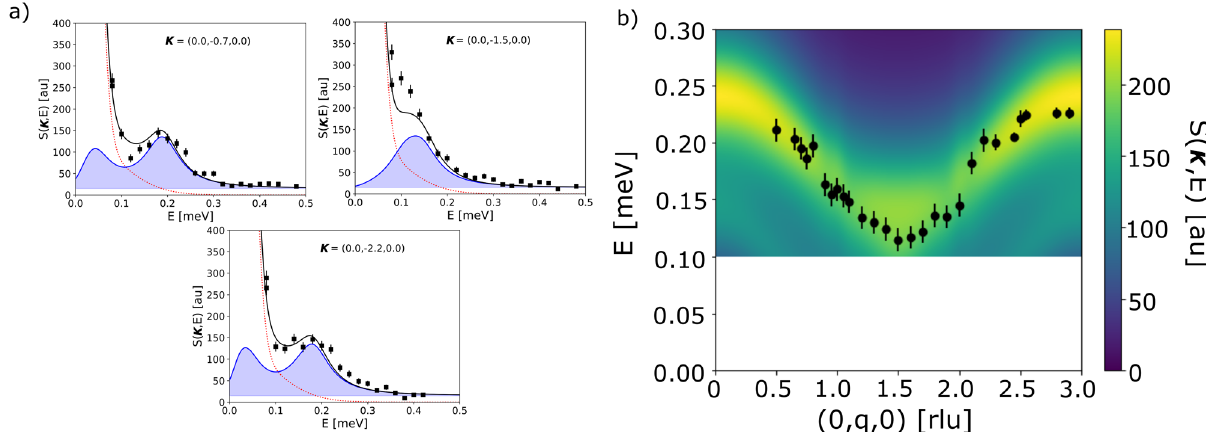
Fig. 2 Spin-wave measurements in ErBr 3 . a Representative inelastic neutron scattering measurements of the spin-wave excitations in ErBr 3 compared with the result of mean- fi eld random-phase approximation (blue lines). The red line is a fi t of the incoherent scattering measured at momentum transfer κ = (2/3, – 4/3,0) and at T = 6K, which is well above the temperature of the phase transition T = 280mK and in the paramagnetic phase where there are no propagating coherent spinwaves.Thesumofbothcontributions isshownbytheblackline.Errorbarsarestandarddeviationsgivenbythesquarerootoftheneutroncounts. b Falsecolor plot of the inelastic neutron cross-section S ( κ , E ) along κ = (0, q ,0). In the calculations, we used a linewidth Γ = 0.07meV in the single-ion susceptibility to approximatetheenergyresolutionofthespectrometer (seeSupplementaryNote3).Thepoints represent thespin-wavedispersioninErBr 3 obtained from a fi twith a single Gaussian. Magnetic excitations below the energy E = 0.1meV were not accessible in the experiment. The error bars are a result of the Gaussian fi